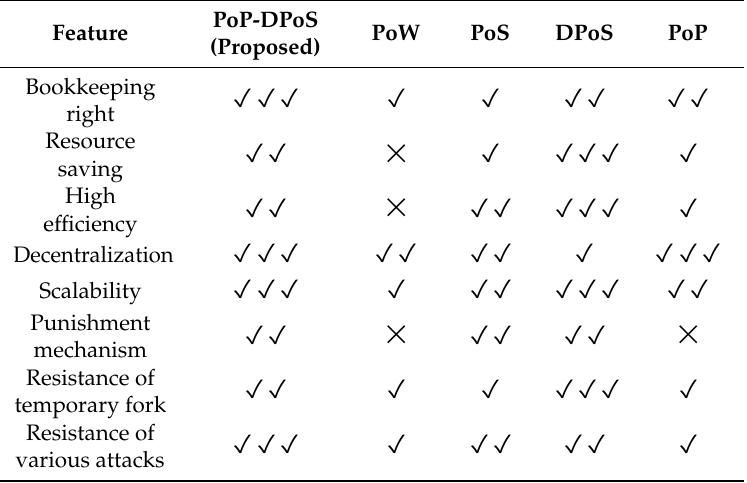
Table 1. Comparison between our proposal with other consensus algorithms.